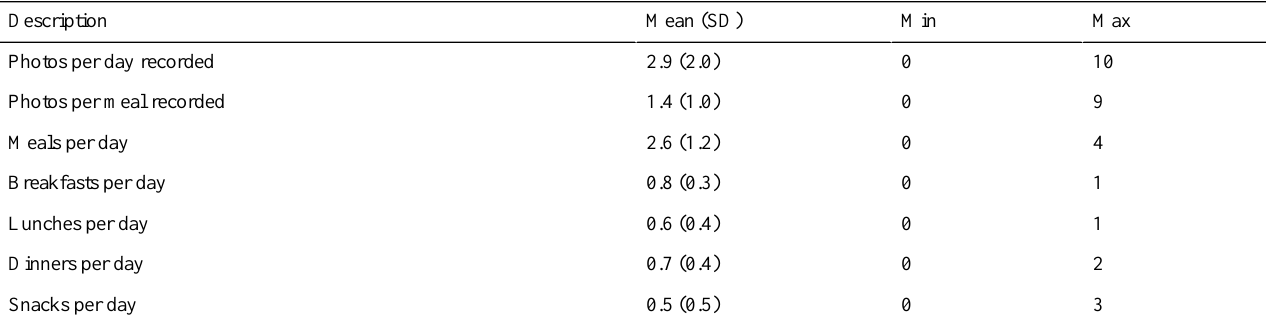
Table 2. Participation descriptive statistics (n=17); CV Health and Needs Assessment Qualitative Study.